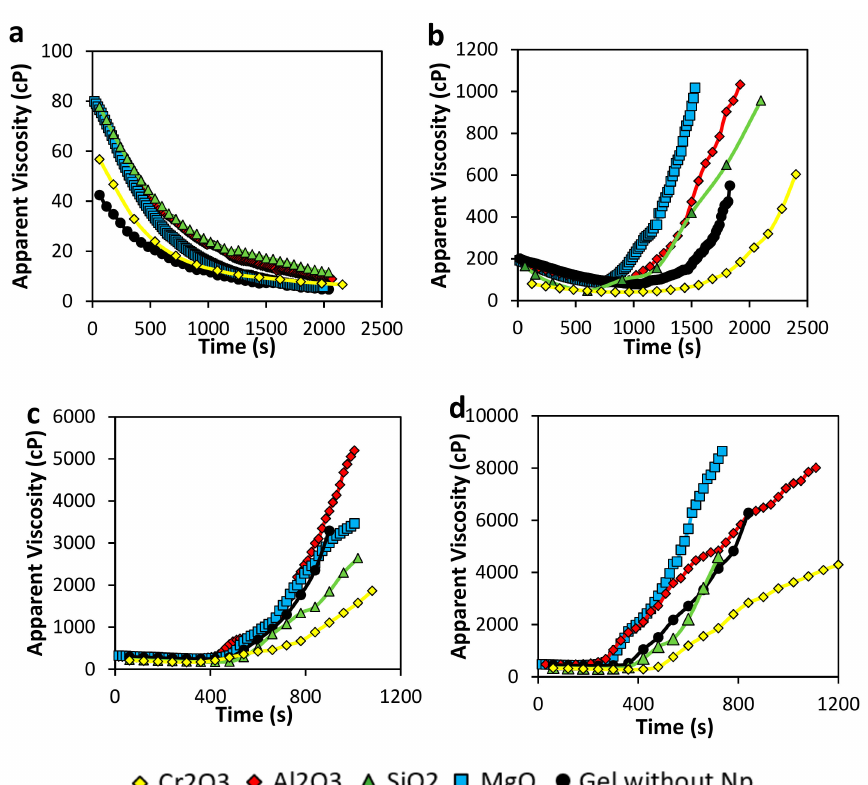
Figure 3. Gelation time of gel samples in the presence and absence of nanoparticles at ( a ) 2000 mg · L − 1 , ( b ) 4000 mg · L − 1 , ( c ) 6000 mg · L − 1 , and ( d ) 8000 mg · L − 1 of polymer concentration and ( a ) polymer to crosslinker ratio of 40:1 at 70 ◦